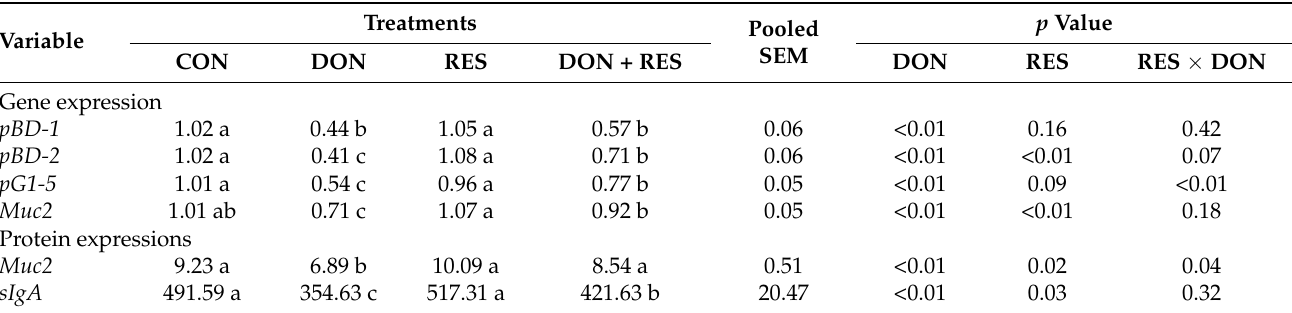
Table 6. Effects of resveratrol on the expression of genes related to innate immunity in the ileal mucosa of weaned piglets challenged with deoxynivalenol 1 .